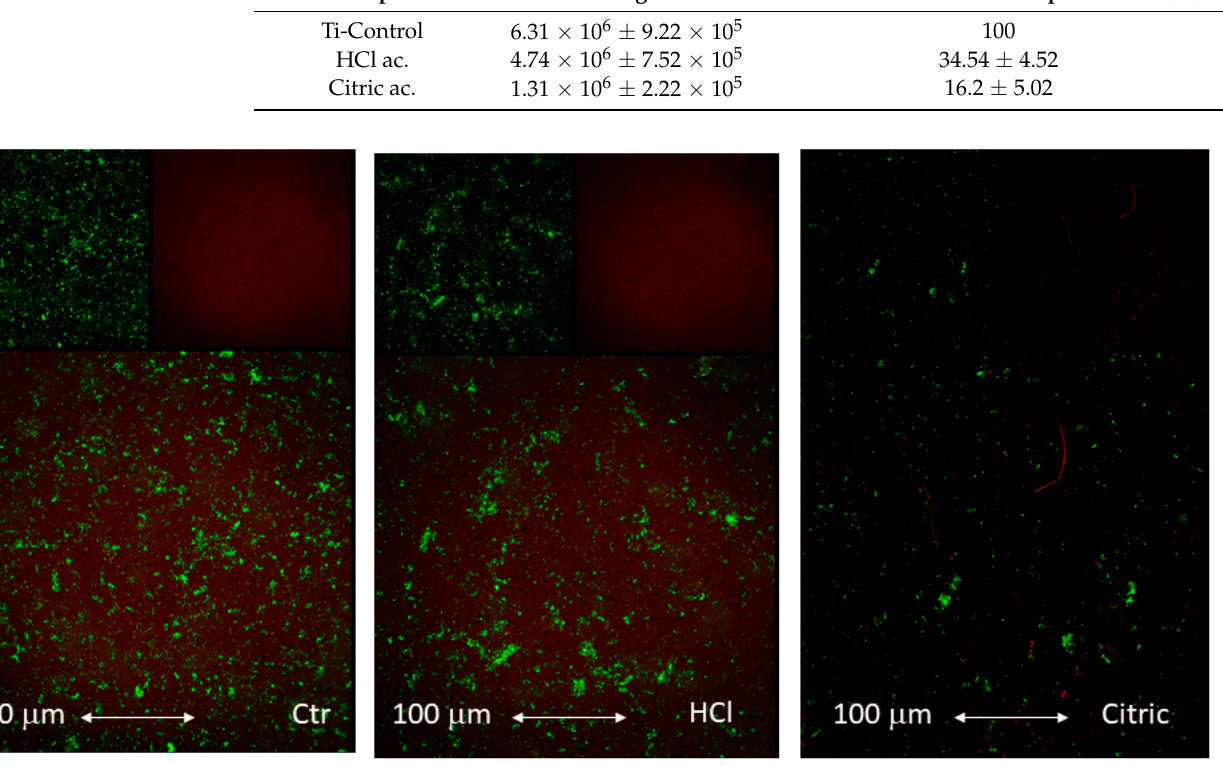
Figure 5. Microscope images of bacteria stained using the Live/Dead ® BacLight bacterial viability kit which allows the assessment of the bacterial viability on each condition. Live: green and dead: dark red.